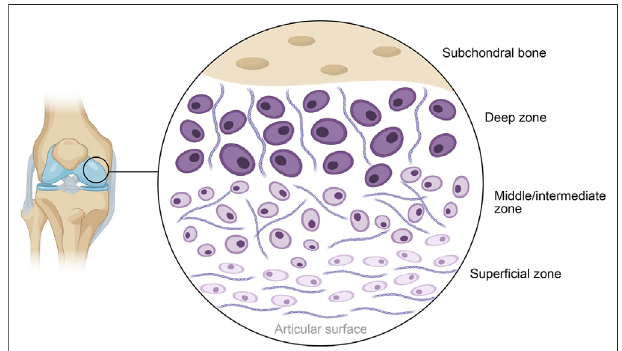
FIGURE 4 | Schematic diagram of the general structure of human articular cartilage, shown in the context of the knee. The deep zone contains hypertrophicchondrocytesinterspersedwithradiallyarrangedcollagen fi bers, progressing to polymorphic chondrocytes and randomly arranged collageninthemiddlelayer.Thesuper fi ciallayerclosesttothearticularsurface contains fl attened chondrocytes packed in between horizontally arranged fi bers of